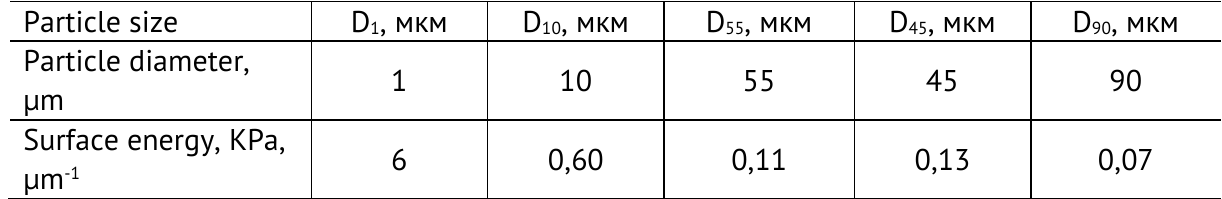
Table 1. Surface energy coefficient of building gypsum